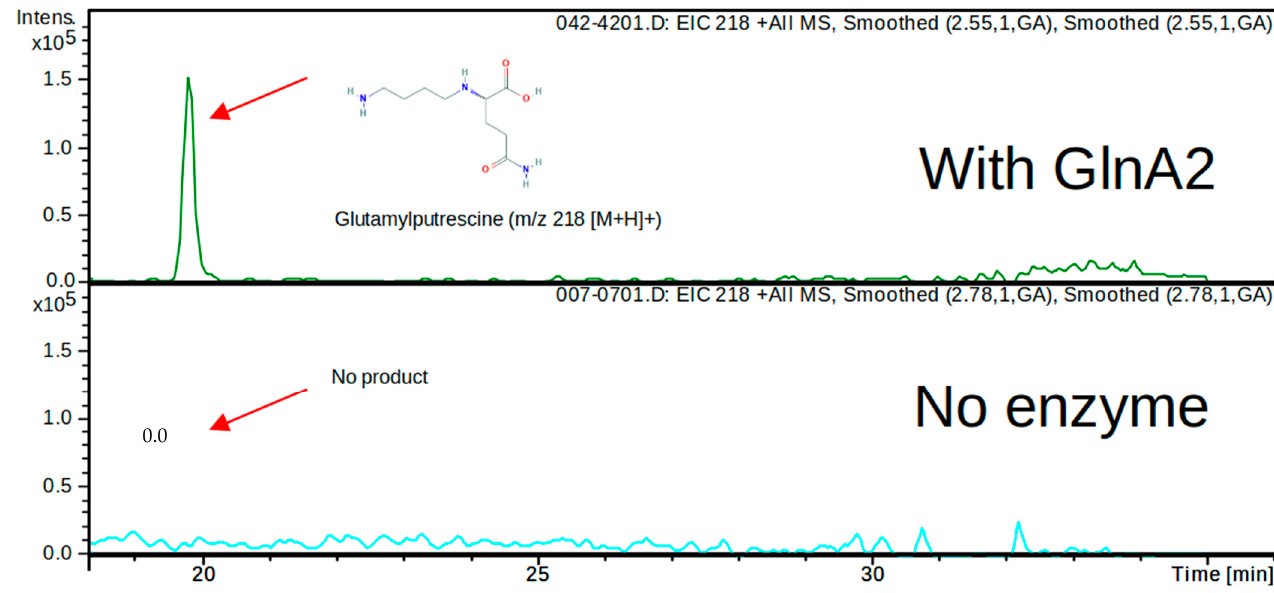
Figure 3. HPLC/ESI-MS analysis of the glutamylated reaction product generated by His-GlnA2. Two samples were analyzed in the MS positive mode (EIC—extracted ion chromatogram): reaction mixtures without addition of GlnA2 (below) and with addition of GlnA2 (above). Extracted ion chromatograms for the GlnA2 reaction product corresponding to gamma-glutamylputrescine with charge to mass ratio of 218 m / z is shown (above), and no product in the sample without GlnA2 could be detected (below). The chromatogram demonstrates detected peaks at the retention time 18 min and later (for full chromatogram see Figure S2).